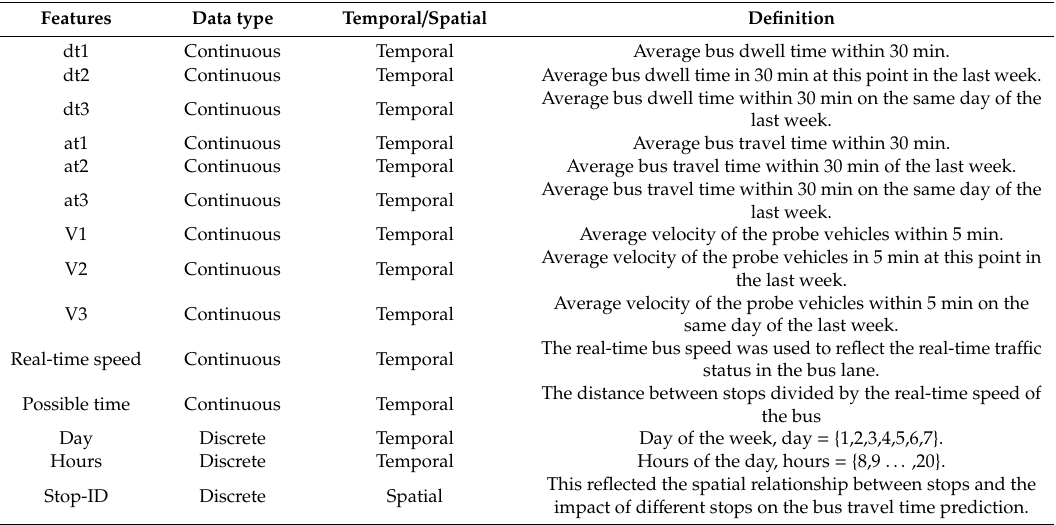
Table 2. Features and